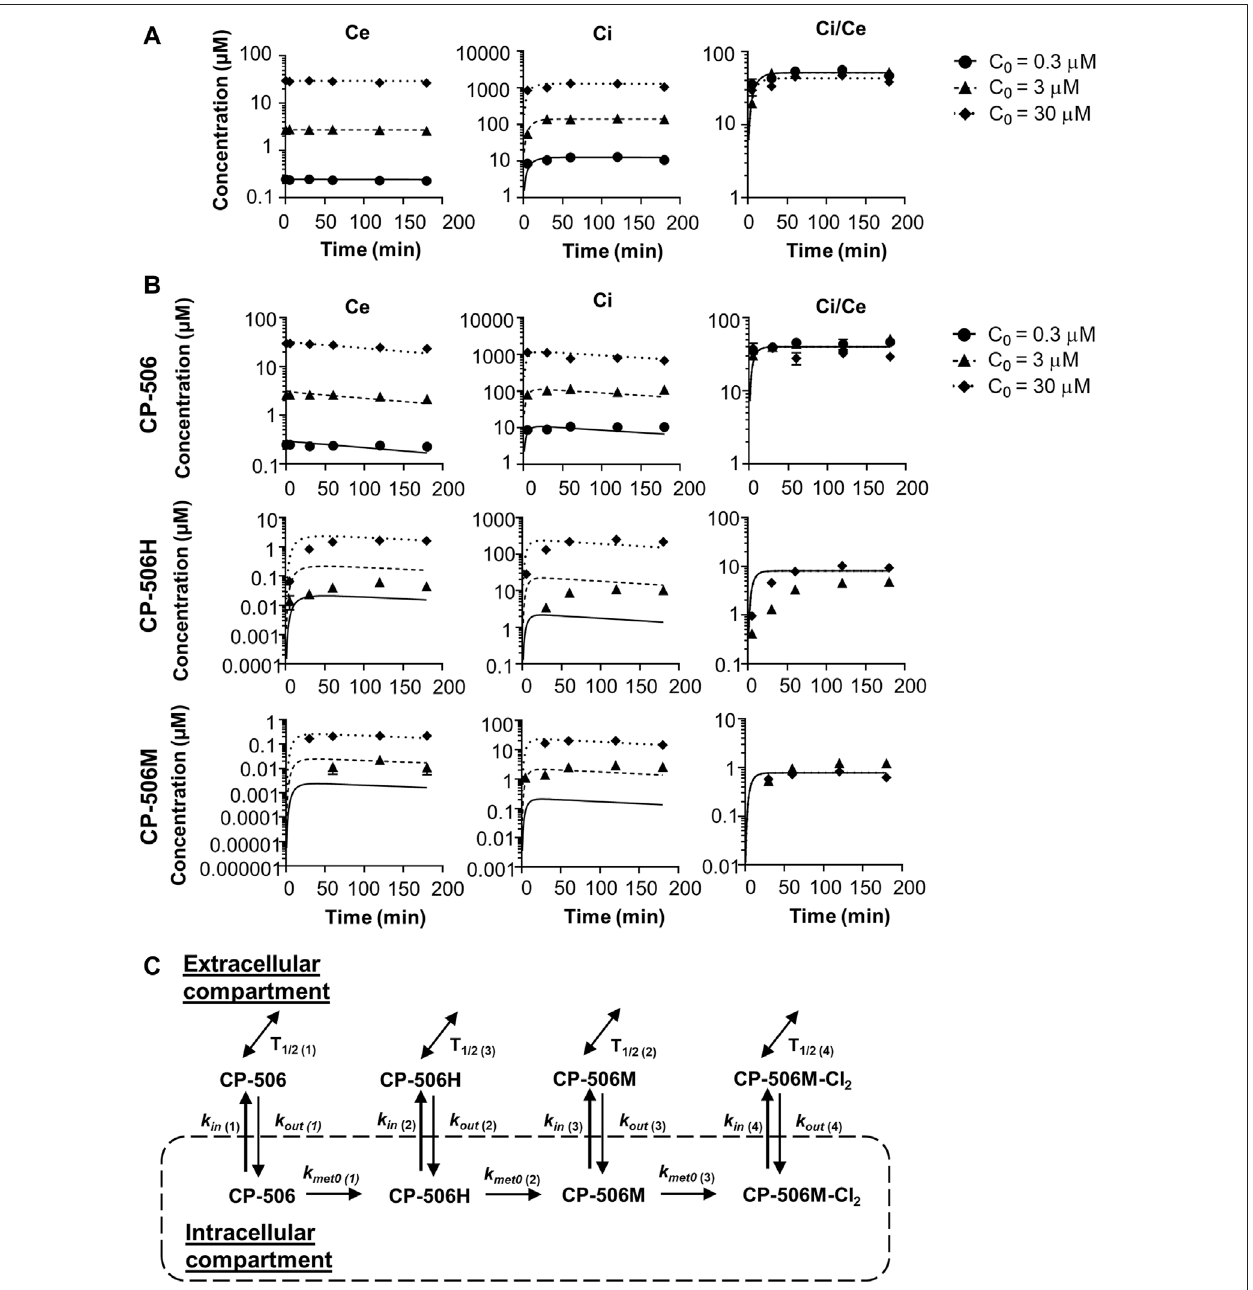
FIGURE4| Cellular PKmodelofCP-506inthetumor tissues. (A) CellularuptakeofCP-506inmonolayerculturesofPOR-Rcellsafterexposuretoarangeofinitial concentrations (C o ) under normoxic conditions (21% O 2 ). Concentrations were determined in the extracellular medium and cellular extracts by mass spectrometry. Graphsshowtheconcentration-timepro fi leofCP-506intheextracellularvolume(C e ),intracellularvolume(C i )andresultantC i /C e ratioovertheexperimentduration(3 h). Values represent the mean ± SEM of three independent experiments. Lines show the corresponding estimates from the cellular PK model as fi tted to the experimentaldata. (B) Hypoxia-selectivemetabolismofCP-506andreleaseofCP-506metabolitesintotheextracellularmediumofPOR-Rcellsunderanoxicconditions ( < 1 ppmO 2 ).Graphsshow theconcentration-time pro fi leofCP-506 andits metabolites CP-506H andCP-506M intheextracellular volume(C e ),intracellular volume (C i ) and resultant C i /C e ratio over the experiment duration (3 h). Data points have been censored if below the lower limits of quanti fi cation (LLOQ, 0.01 µM). Lines show the corresponding estimates from the cellular PK model. (C) Cellular PK model for CP-506. The concentration of CP-506 and its metabolites in the extracellular and intracellular compartments is de fi ned by the permeability rate constants (k in and k out ). The bioreductive metabolism of CP-506 (k met0 ) is O 2 -dependent and restricted to the intracellular compartment. The stability of each compound is de fi ned by their respective half-life (T 1/2 ). Model estimates for the given parameters are provided in Supplementary Table S3